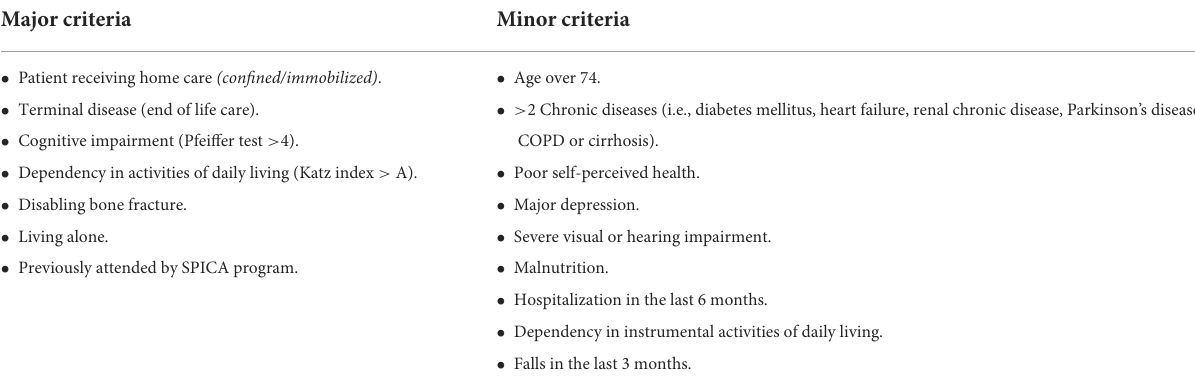
TABLE 1 Inclusion criteria for the SPICA program. Inclusion criteria (at least, 1 major or 3 minor